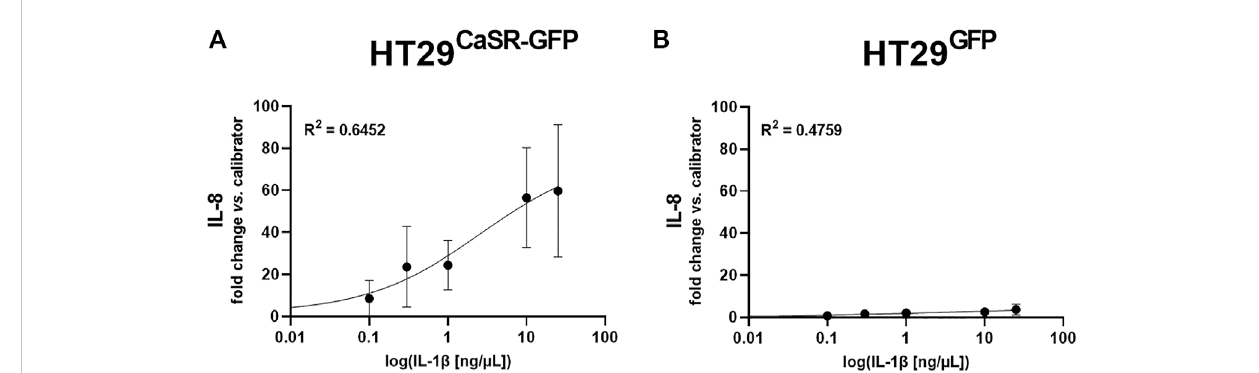
FIGURE 5 Induction of IL-8 gene expression via IL-1 β is enhanced when the CaSR is present. Dose-response curve of relative gene expression of IL-8 in (A) HT29 CaSR − GFP cells and (B) HT29 GFP cells after 4 h treatment with IL-1 β (0.1 ng/ μ L – 25 ng/ μ L). Mean ± SD, N = 3 – 4. Sigmoidal 4-parameter fi t, 0-